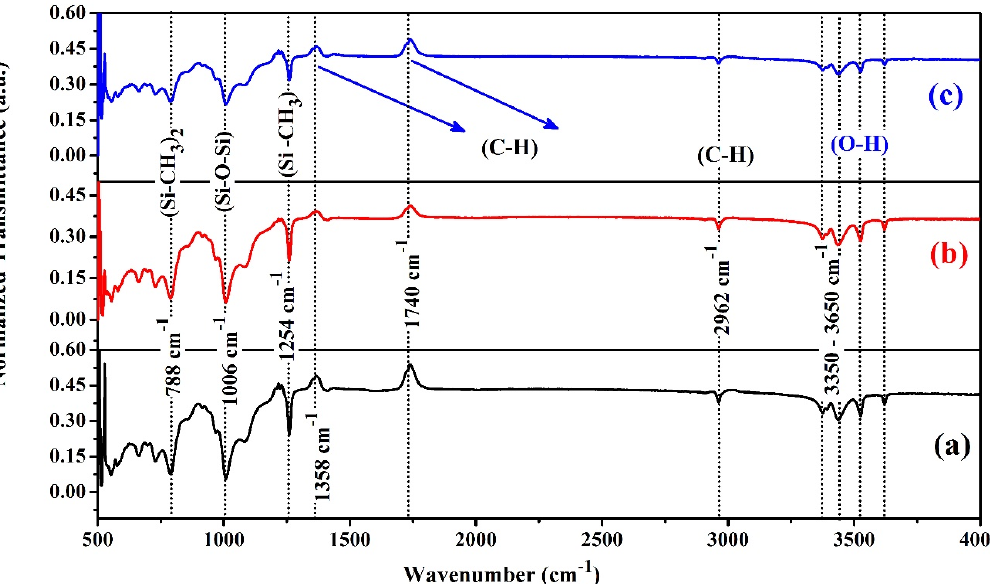
Figure 11. FTIR-Spectrum of the highly eroded and tracked samples: ( a ) Fresh, ( b ) Thermal-aged, Figure 11. FTIR ‐ Spectrum of the highly eroded and tracked samples: ( a ) Fresh, ( b ) Thermal ‐ aged, ( c ) ( c ) Water ‐ aged.